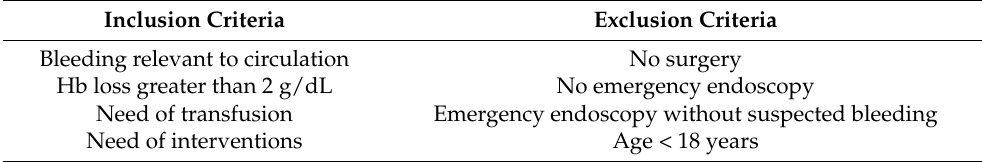
Table 1. Inclusion and exclusion criteria.